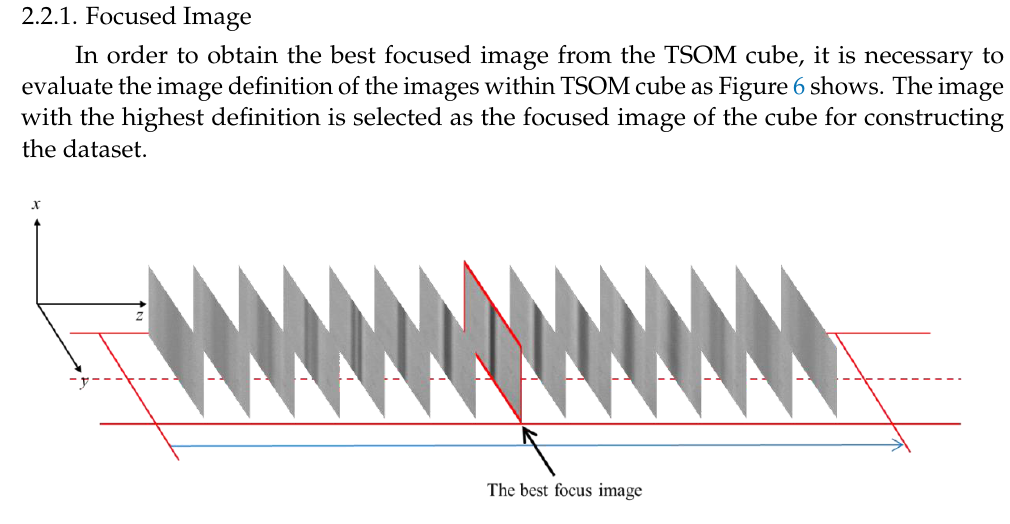
Figure 6. Evaluate the definition of the images and select the best focused